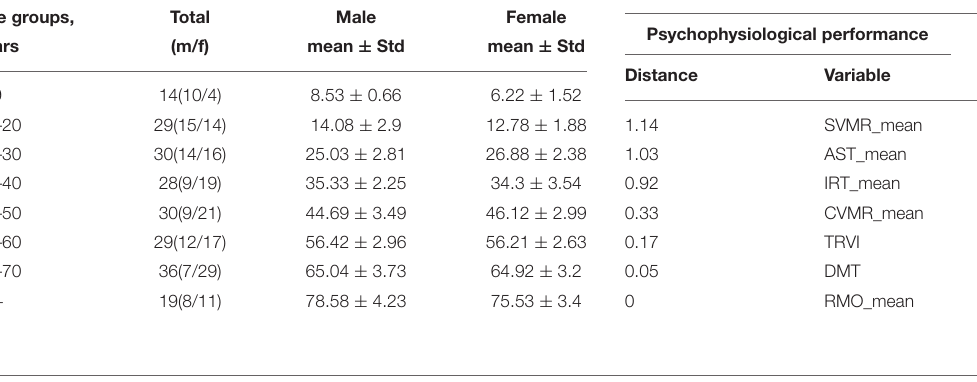
TABLE 3 | Demographics of subjects.